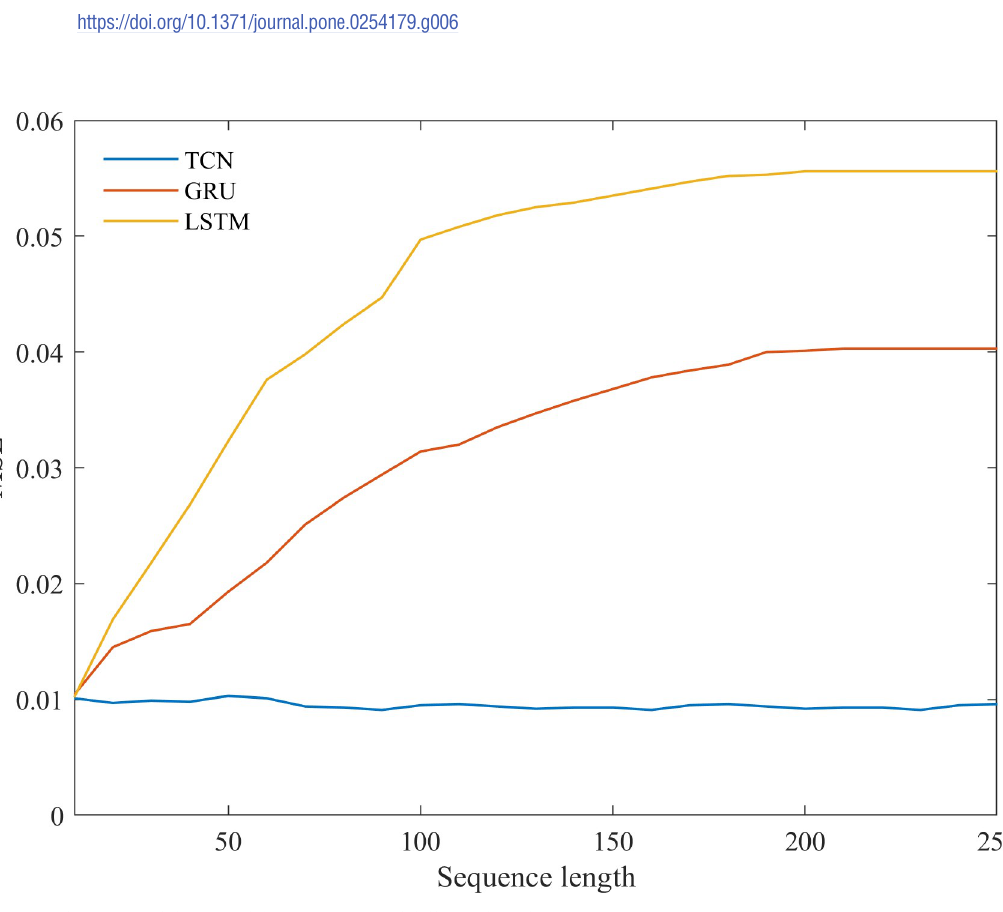
Fig 6. Results of noise reduction of five parameters by WT. (a) Ammonia sequence. (b) Temperature sequence. (c) Relative humidity sequence. (d) CO 2 sequence. (e) TSP sequence.